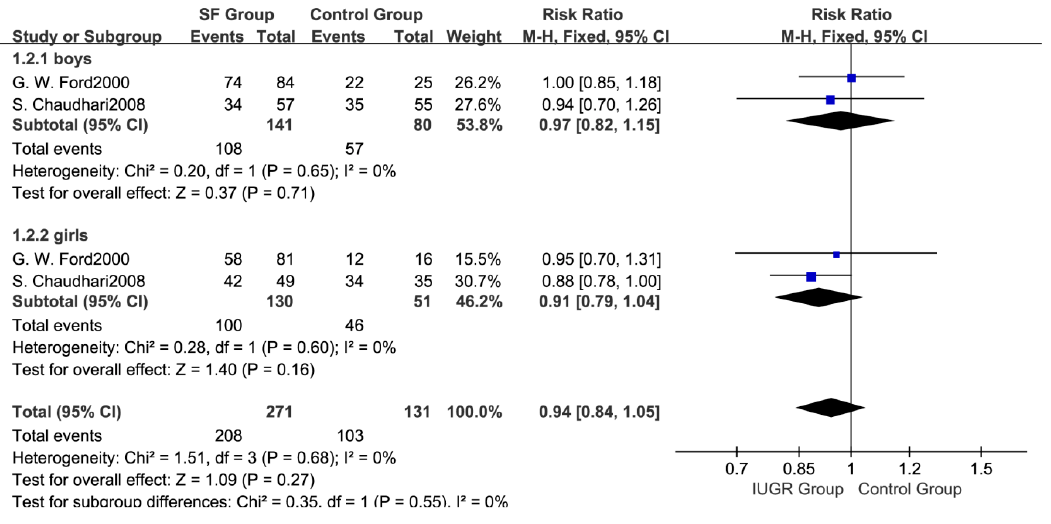
Figure 3. Forest plot for the number of pubertal children in boys and girls between SF group and Control group.